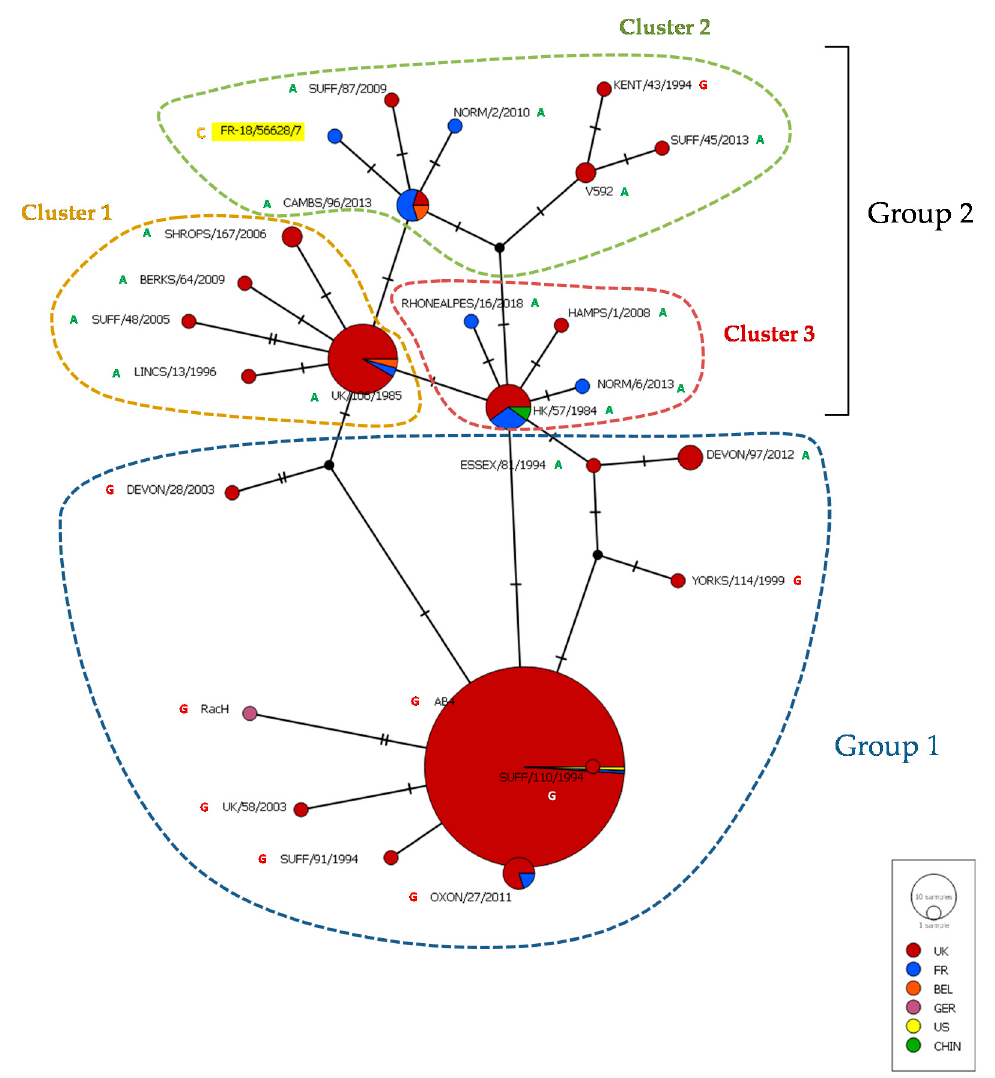
Figure 6. Median joining network representing ORF30 nucleotide sequences of Ab4 and V592 reference strains, 67 EHV-1 strains previously described [50] and 15 EHV-1 strains from France and Belgium [22], including the newly isolated EHV-1 strain FR-56628 (highlighted in yellow). The ORF30 position 2254 nucleotide is annotated.